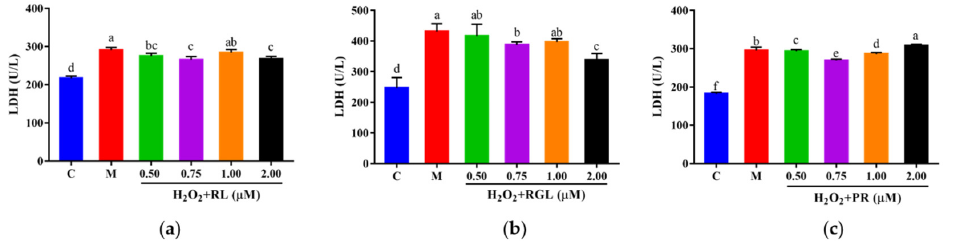
Figure 12. LDH level of HepG2 cells with oxidative stress treated with synthetic peptides: ( a ) synthetic peptide RL; ( b ) synthetic peptide RGL; ( c ) synthetic peptide PR. “C” represents the control group, and “M” represents the model group. Data were expressed as mean ± SD ( n ≥ 3, p < 0.05). Different letters indicate significant differences ( p < 0.05).